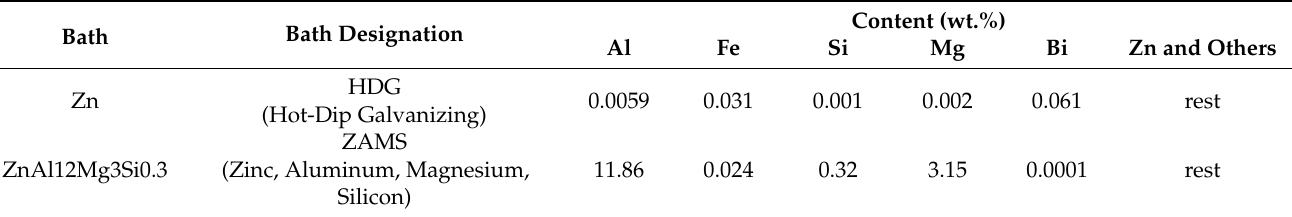
Table 2. Chemical composition of research